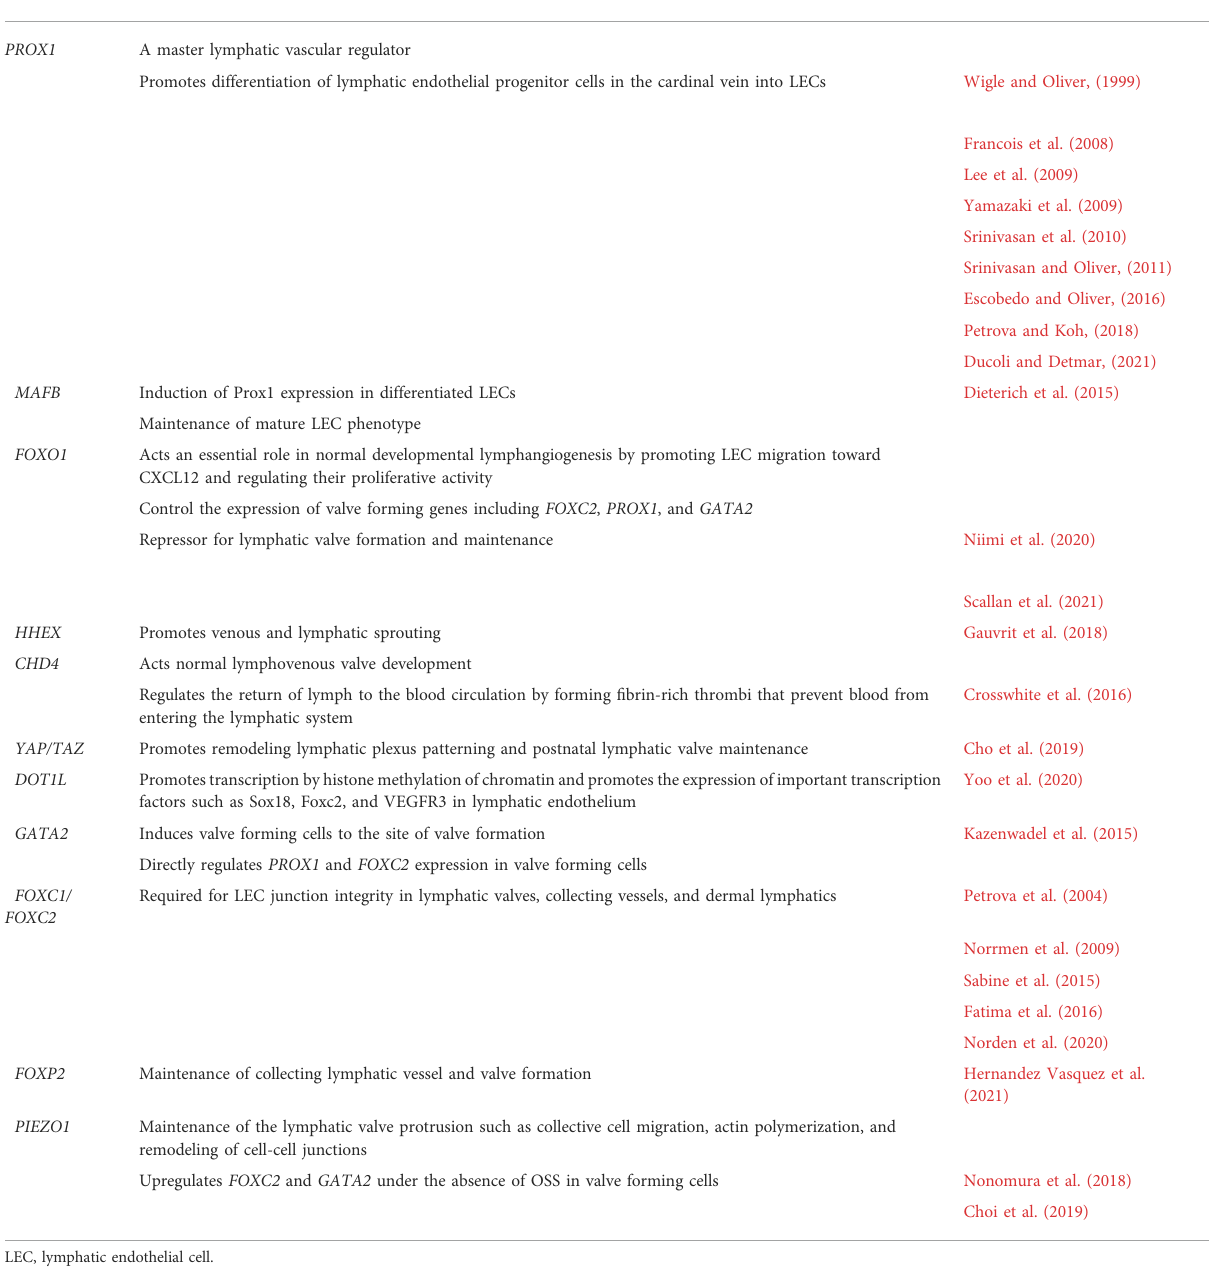
TABLE 1 Factors involved in transcriptional regulation regarding lymphatic vascular